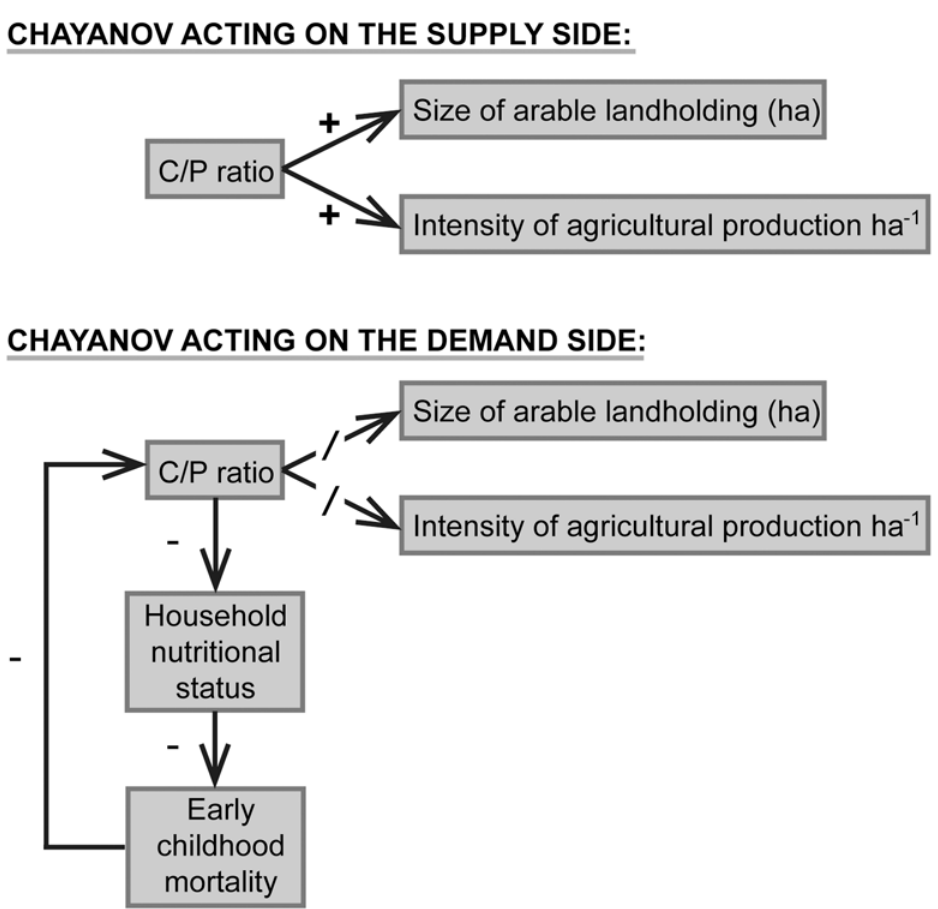
Fig 1. The conventional model that has C/P ratio acting purely on the supply side of the household economy (top) and an extended model that allows for possible effects on the demand side when supply-side responses are blocked or impeded (bottom). Pluses and minuses indicate the direction of the bivariate relationship between boxes.